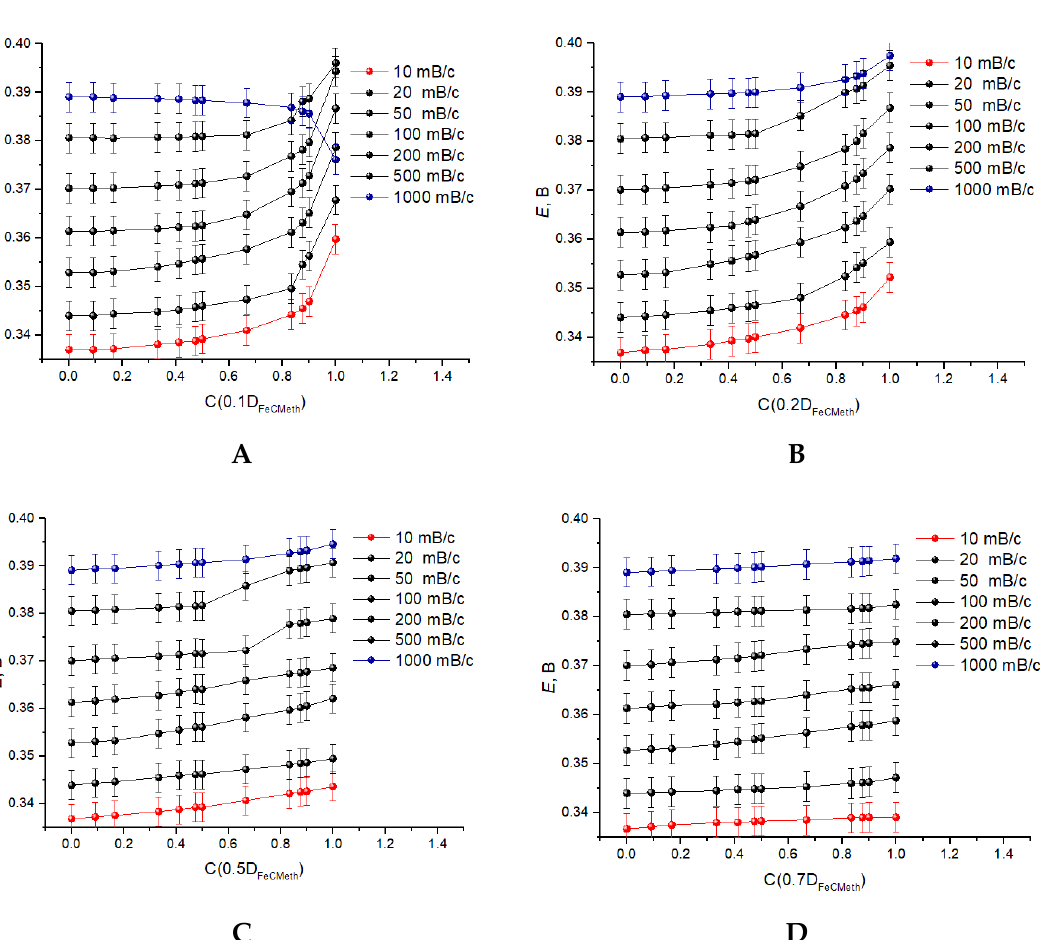
Figure 20. The dependence of the oxidation peak potential on the fraction of a high molecular weight compound for different sweep rates: ( A )—D HMWC = 0.1 × D FeCMeth , ( B )—D HMWC = 0.2 × D FeCMeth, ( C )—D HMWC = 0.5 × D FeCMeth, ( D )—D HMWC = 0.7 × D FeCMeth